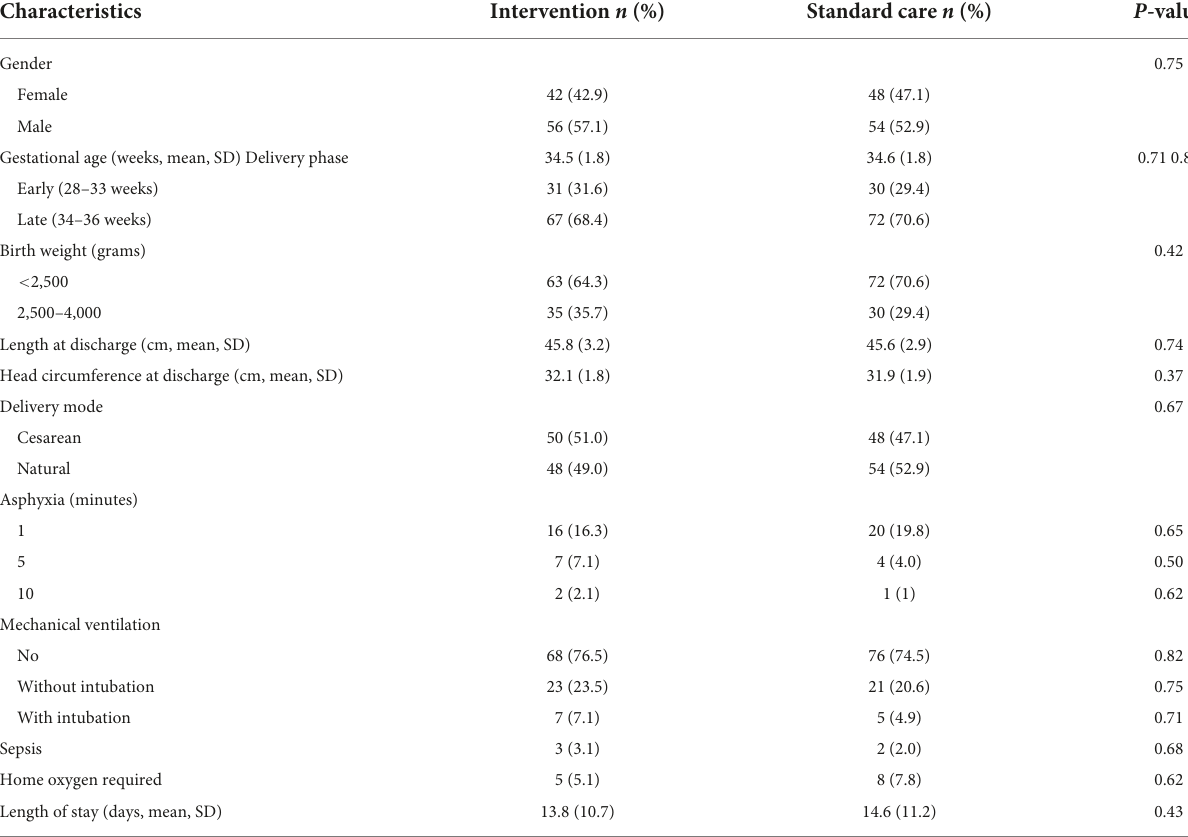
TABLE 1 Comparison of infant clinical characteristics between the intervention ( n = 98) and standard care groups ( n = 102). Characteristics Intervention n